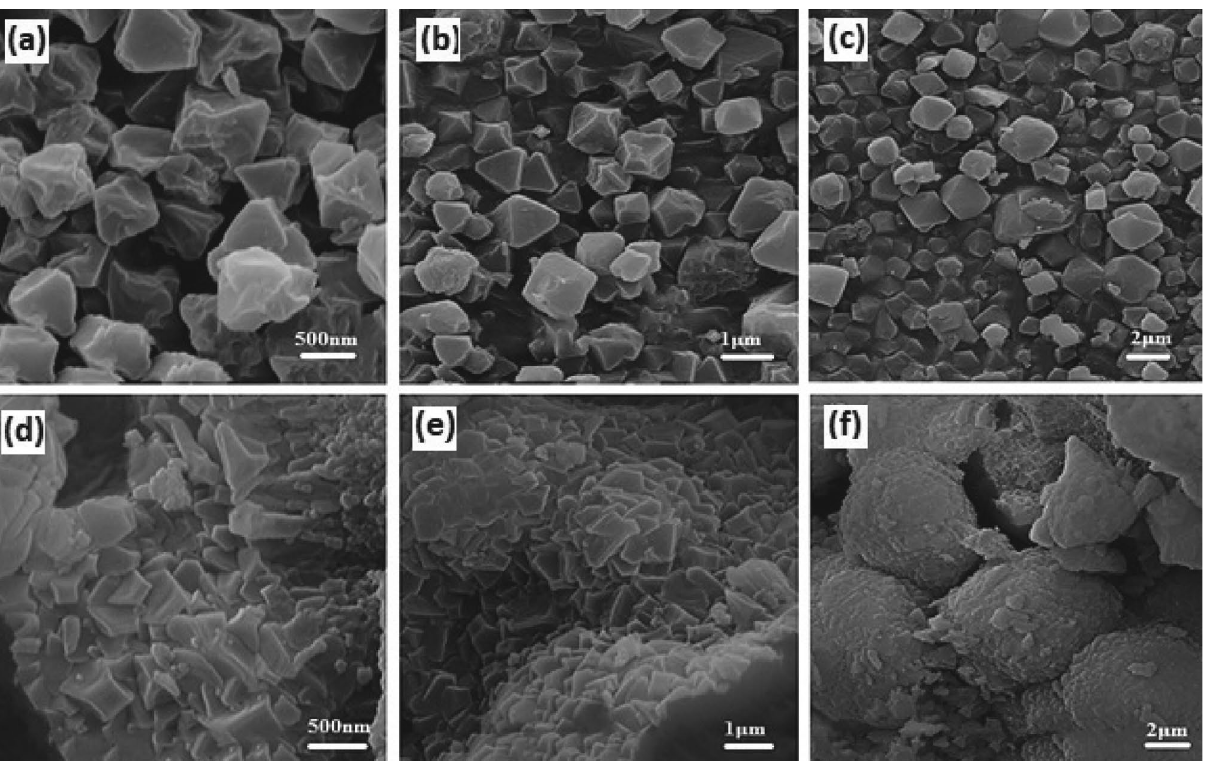
Figure 4. SEM images of (a-c) MIL-101 (Cr) and (d-f) P 2 W 18 @MIL-10 (Cr) at different Jarrah and Farhadi: Dawson-Type Polyoxometalate Incorporated into Nanoporous ...